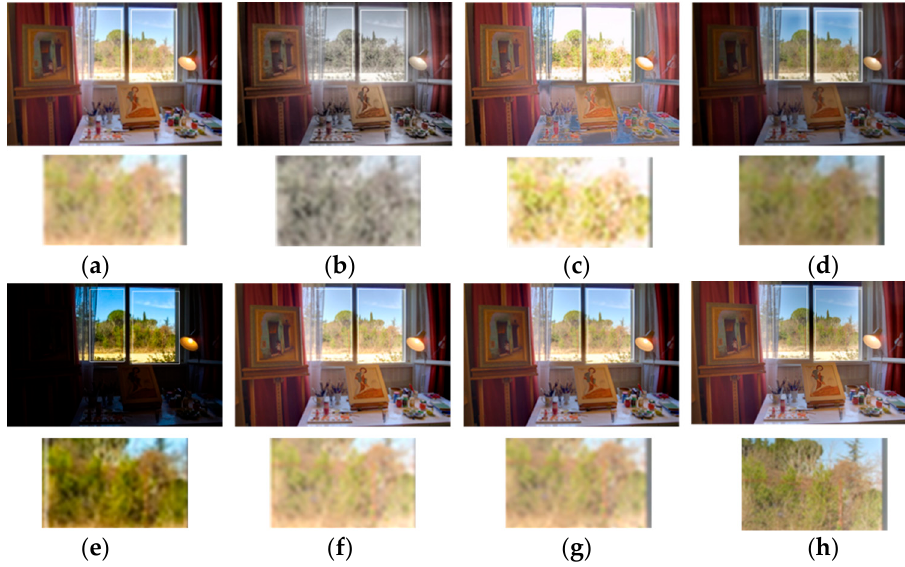
Figure 7. Results of different methods on the image sequence “Studio”. ( a ) Mertens et al. [12]. ( b ) Gu et al. [16]. ( c ) Shen et al. [18]. ( d ) Bruce et al. [19]. ( e ) Photomatix [36]. ( f ) Hayat et al. [21]. ( g ) Huang et al. [22]. ( h ) Proposed method.